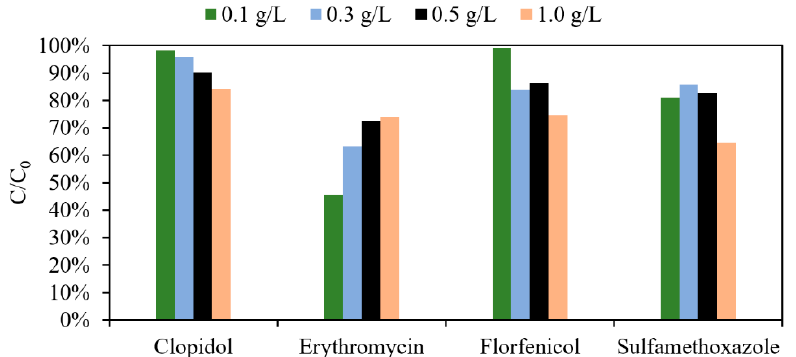
Figure 11. Degradation of target antibiotics using UV/TiO 2 photocatalysis for 60 min at different TiO 2 loadings.